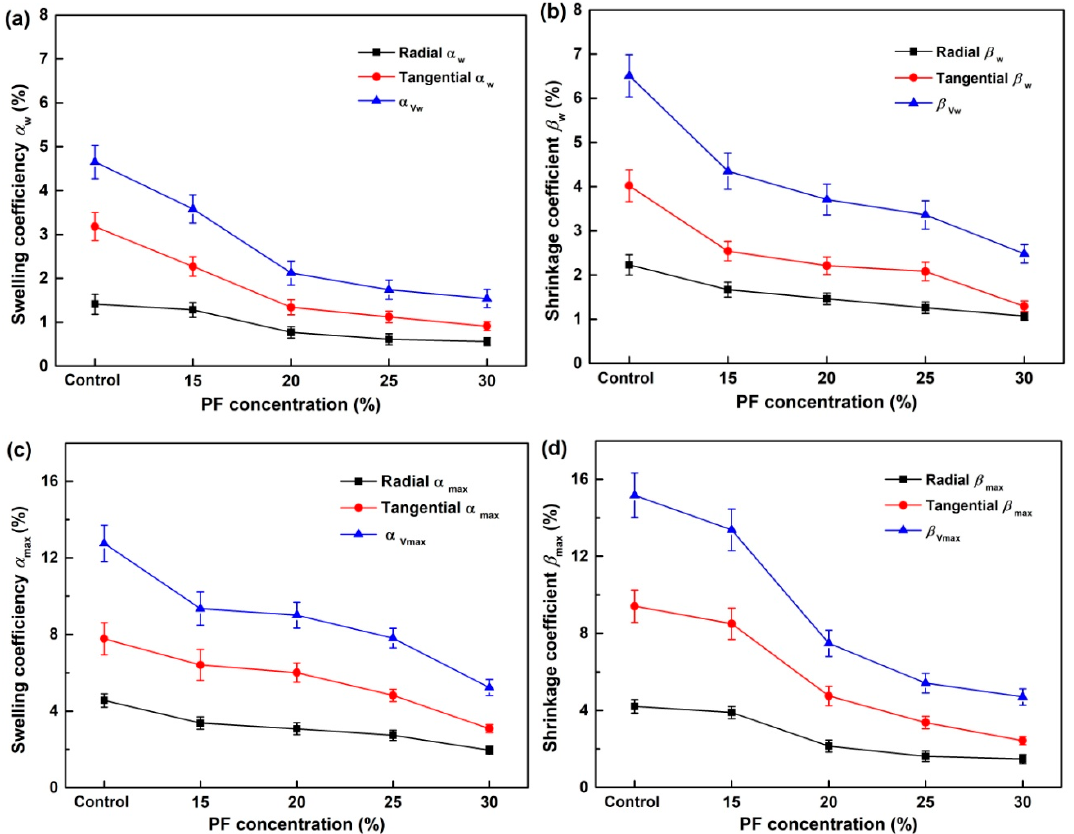
Figure 5. The swelling and shrinking coe ffi cients of the control and modified wood: ( a ) and ( b ) swelling and shrinking coe ffi cients from oven-dried to wet; ( c ) and ( d ) swelling and shrinking coe ffi cients from oven-dried to air-dried.